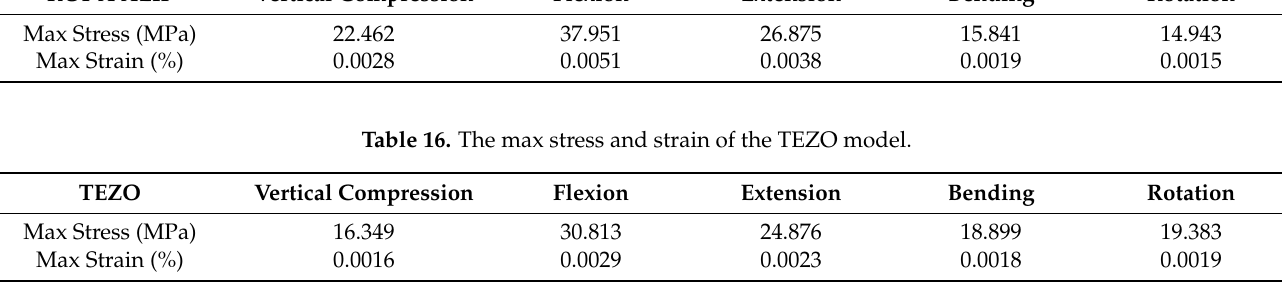
Table 18. The max stress and strain of the designed cage.